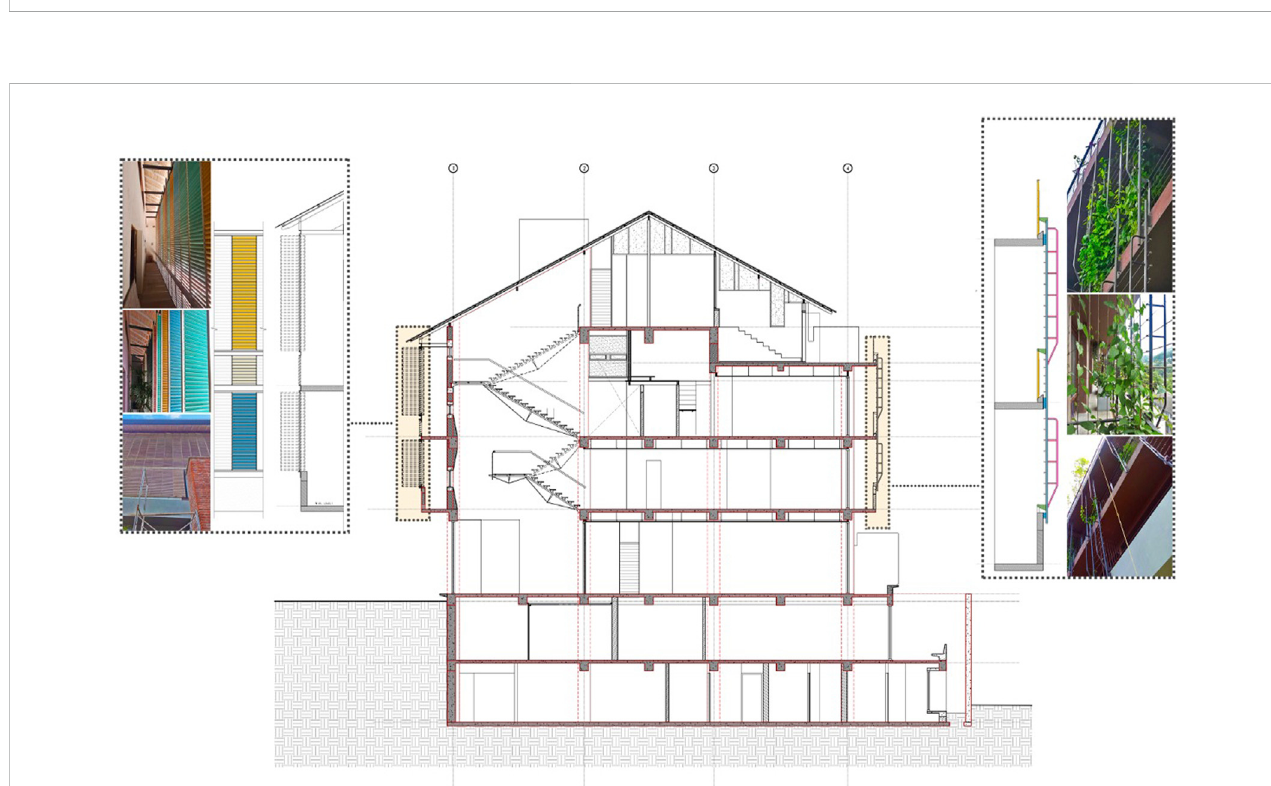
Frontiers in Built